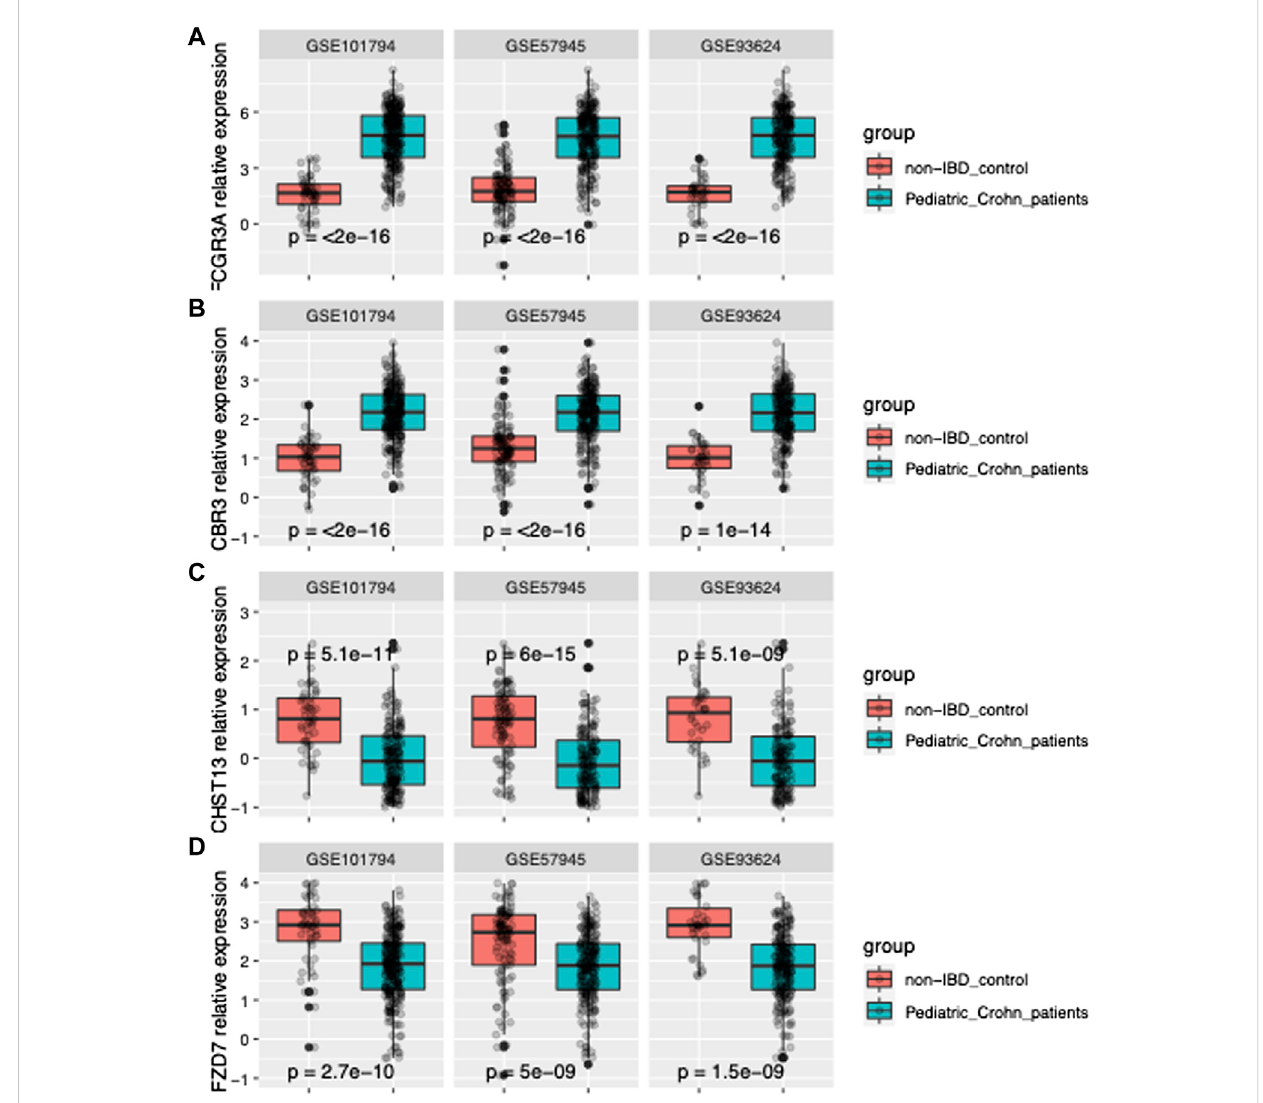
FIGURE 2 Gene expression of FCGR3A, CBR3, CHST13, and FZD7 in three datasets. (A) Boxplot of FCGR3A gene expression in GSE101794, GSE57945 and GSE93624 datasets, representing the pediatric Crohn ’ s Disease (PD) and control samples. The center line of the box represents the median expression level,thetopandbottomedgesoftheboxrepresentthe75thand25thpercentiles,respectively,andthewhiskersextendtothemostextremedatapoints within 1.5 times the interquartile range. The red dots represent outliers. (B) Boxplot of CBR3 gene expression in GSE101794, GSE57945 and GSE93624 datasets. (C) Boxplot of CHST13 gene expression in GSE101794, GSE57945 and GSE93624 datasets. (D) Boxplot of FZD7 gene expression in GSE101794, GSE57945 and GSE93624